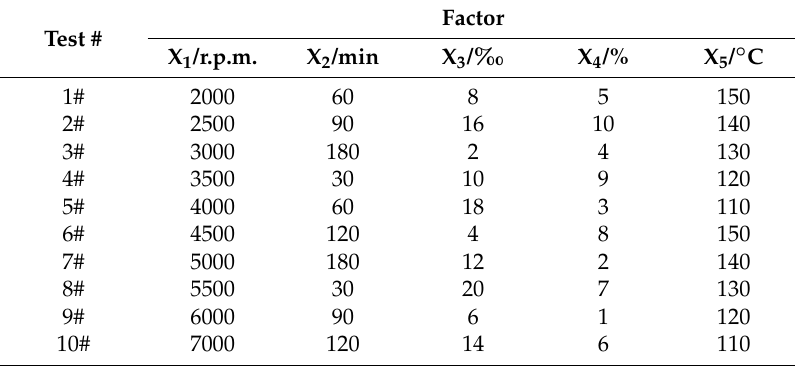
Table 5. Test combinations design